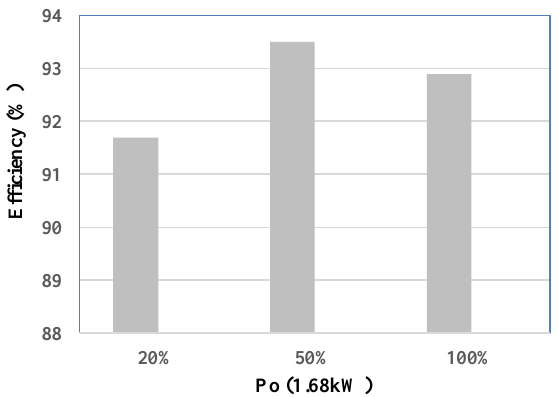
Figure 13. Measured waveforms of the lagging-leg switch S 4 at 800 V input ( a ) 50% load and ( b ) full load (v S4,g : 10 V/div; v S4,d : 200 V/div; i S4 : 2 A/div; time: 2  s/div).